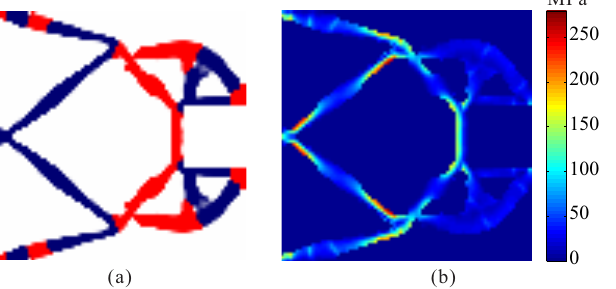
Figure 8. The convergence history for topological design of multi-material compliant gripper with global stress constraints ( σ ∗ = 180 MPa, σ ∗ = 280 MPa). ( a ) Optimal topology; ( b ) stress distribution.